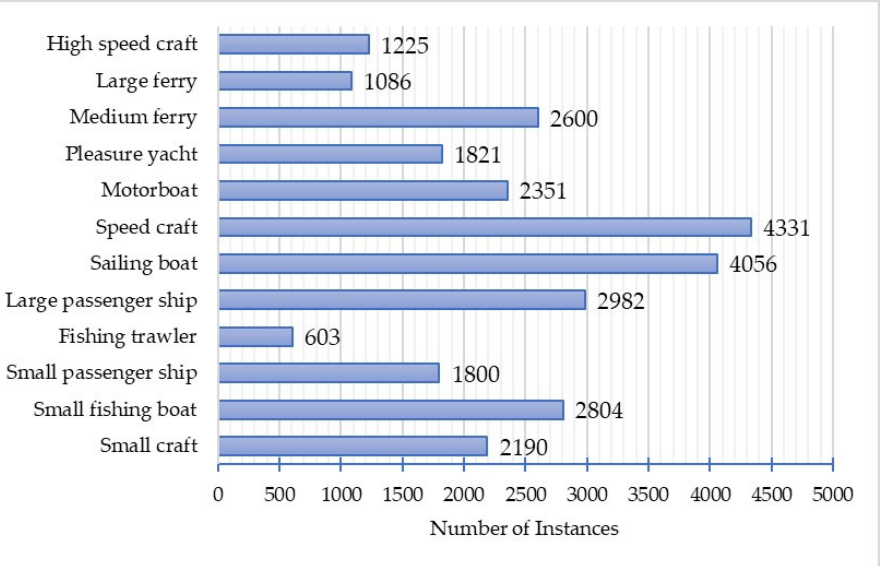
Figure 5. Distribution histogram of class annotations.